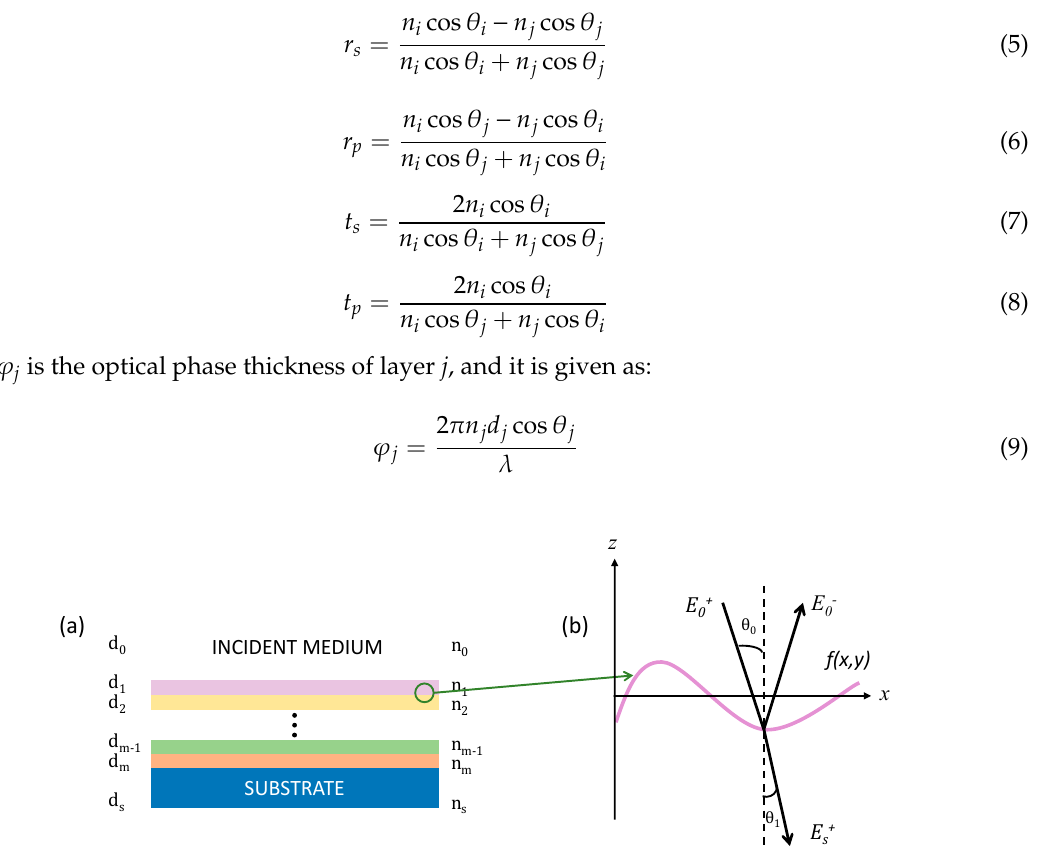
Figure 1. ( a ) Schematic diagrams of the steep-edge filters; ( b ) the profile of the rough surface [21,24].